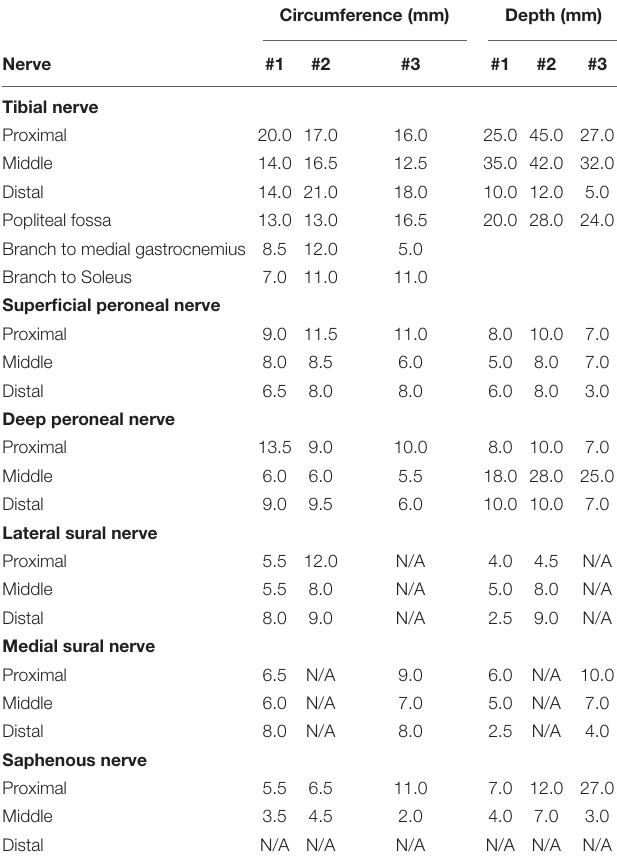
TABLE 2 | Lower extremity nerve